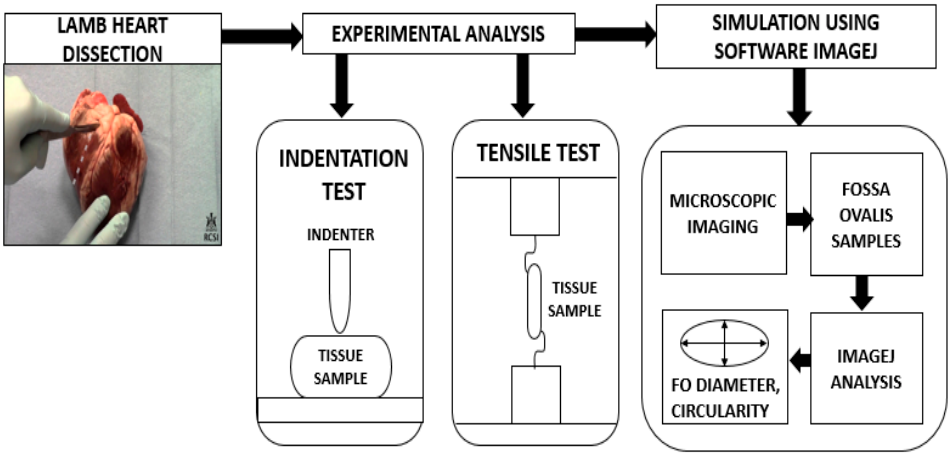
Figure 2. Schematic of experimental and simulation experiments.